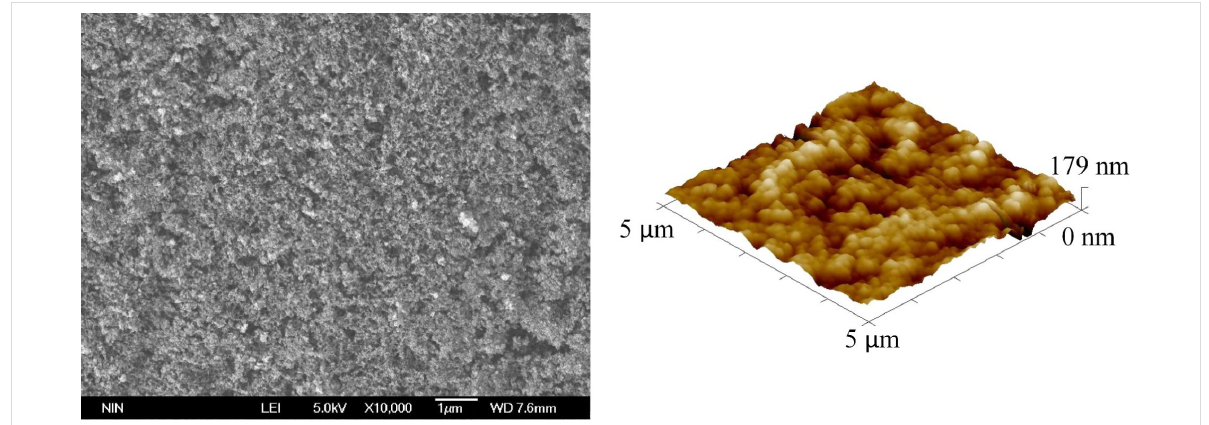
Figure 7: SEM and AFM image of the electrode contact area (after charging for 2 min at 2000 V) in the coating.